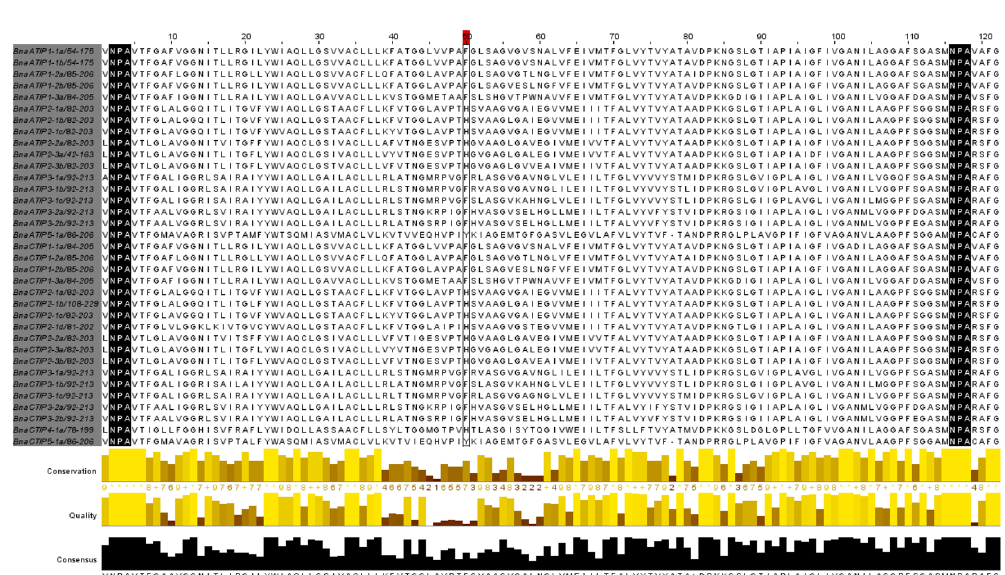
Figure 5. Alignment of Brassica napus TIPs showing 5 th selectivity filter newly identified in Arabidopsis AtTIP2-1.